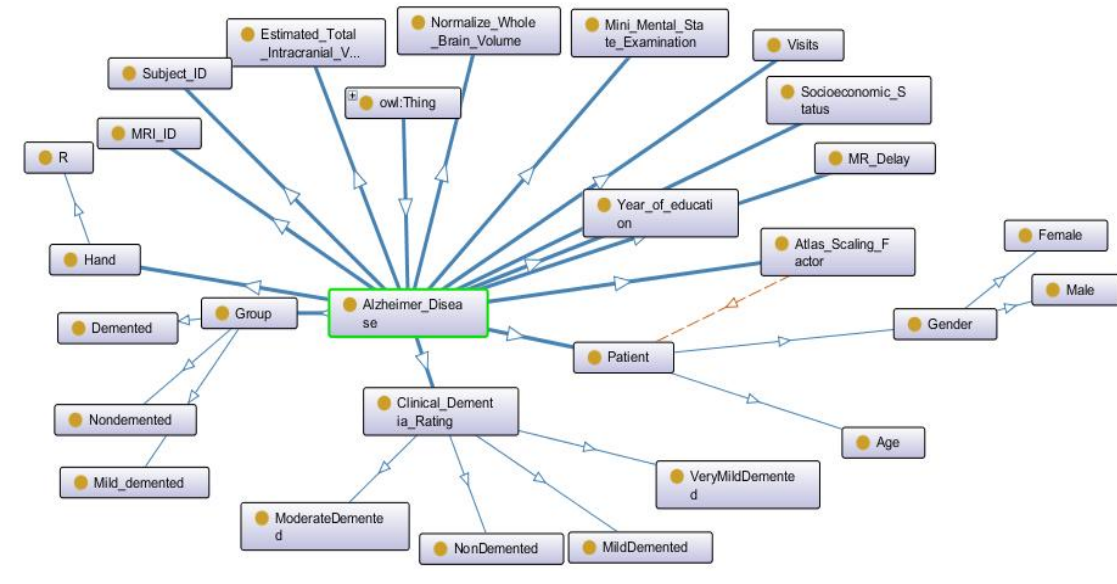
Figure 19. Alzheimer Disease in Protégé Software.